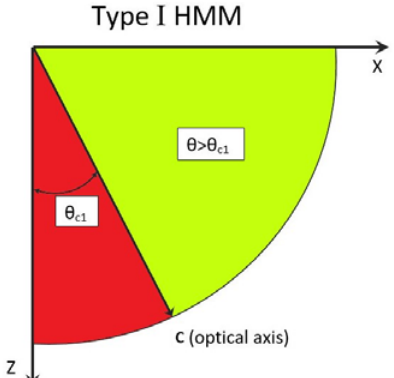
Figure 6: Schematic view of the range of angles θ>θ ) for which localized plasmon-polaritons exist ( 1 c at the boundary of the I type HMM on the basis of Ti O /Ag nanostructure. 3 5